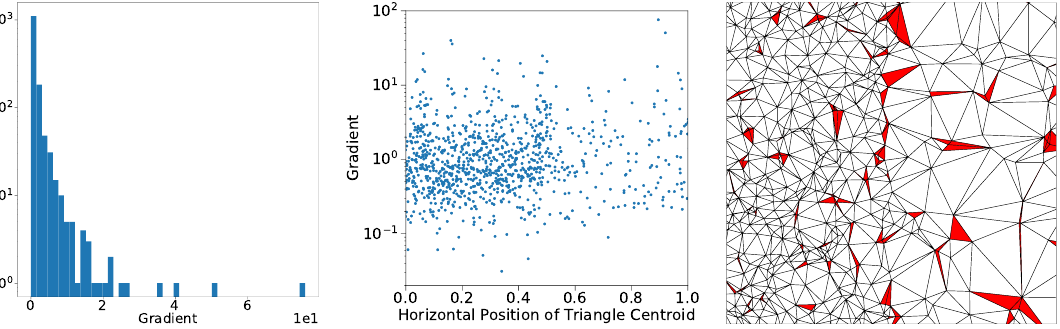
Figure 7 . The same as figure 6, but after rescaling the calculated gradients as in eq.